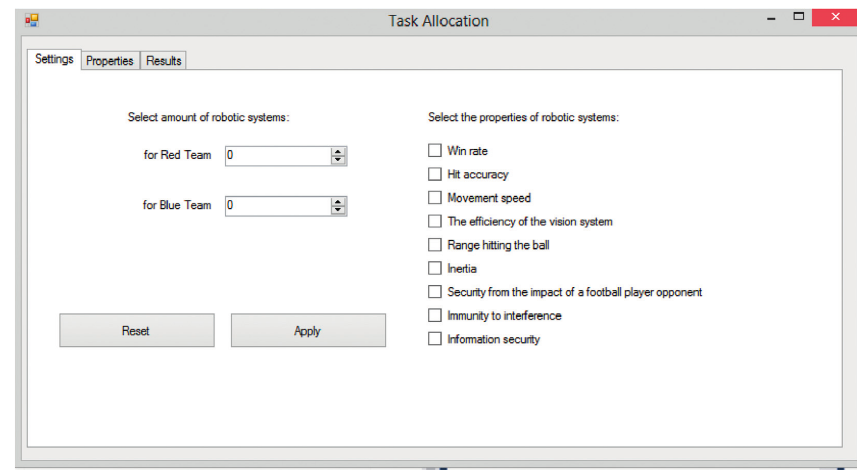
Figure 3: Main software modal window.